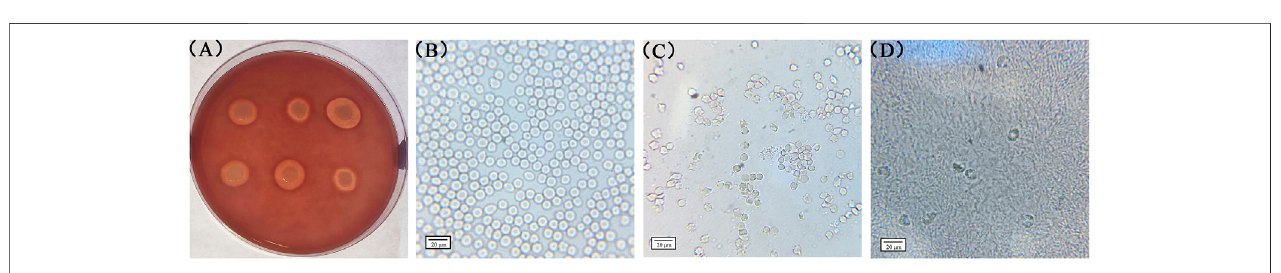
FIGURE 3 | Rabbit red blood cells treated with different bacterial strains. Note: (A) presents the results observed on rabbit blood agar plates; (B) , (C) , and (D) present the results observed through biological microscopy.